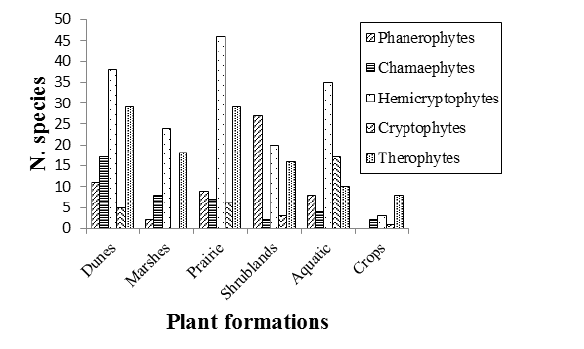
Figure 5. Comparison of the biological spectrum (by number of species) in the plant formations determined in the study area.